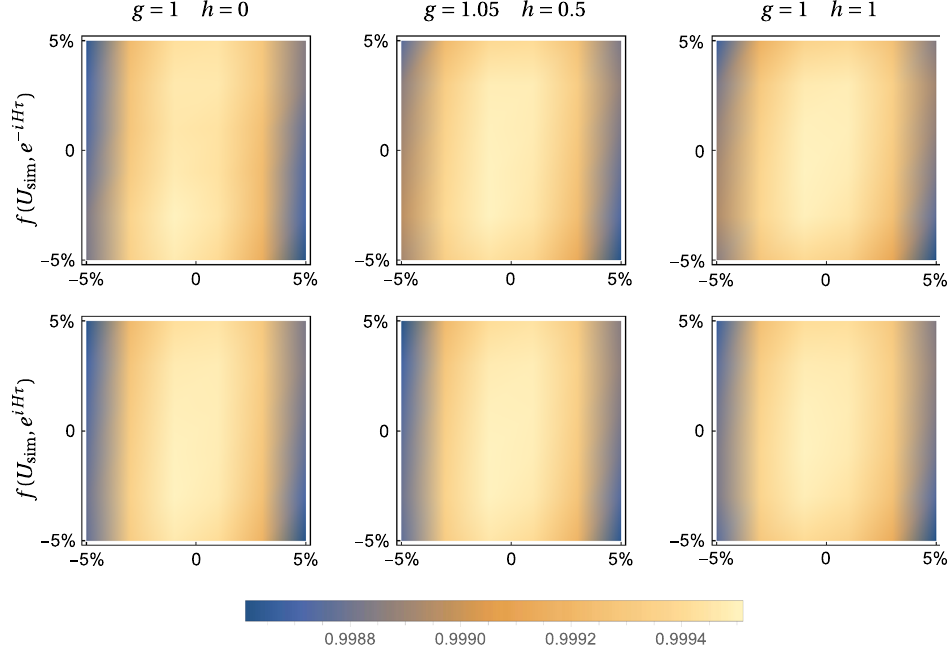
FIG. 8. Robustness of the used GRAPE pulses against rf field inhomogeneity. Here, the transverse axis denotes relative error of output field power of the 13 C channel and the longitudinal axis is that of the 19 F channel. U fidelity